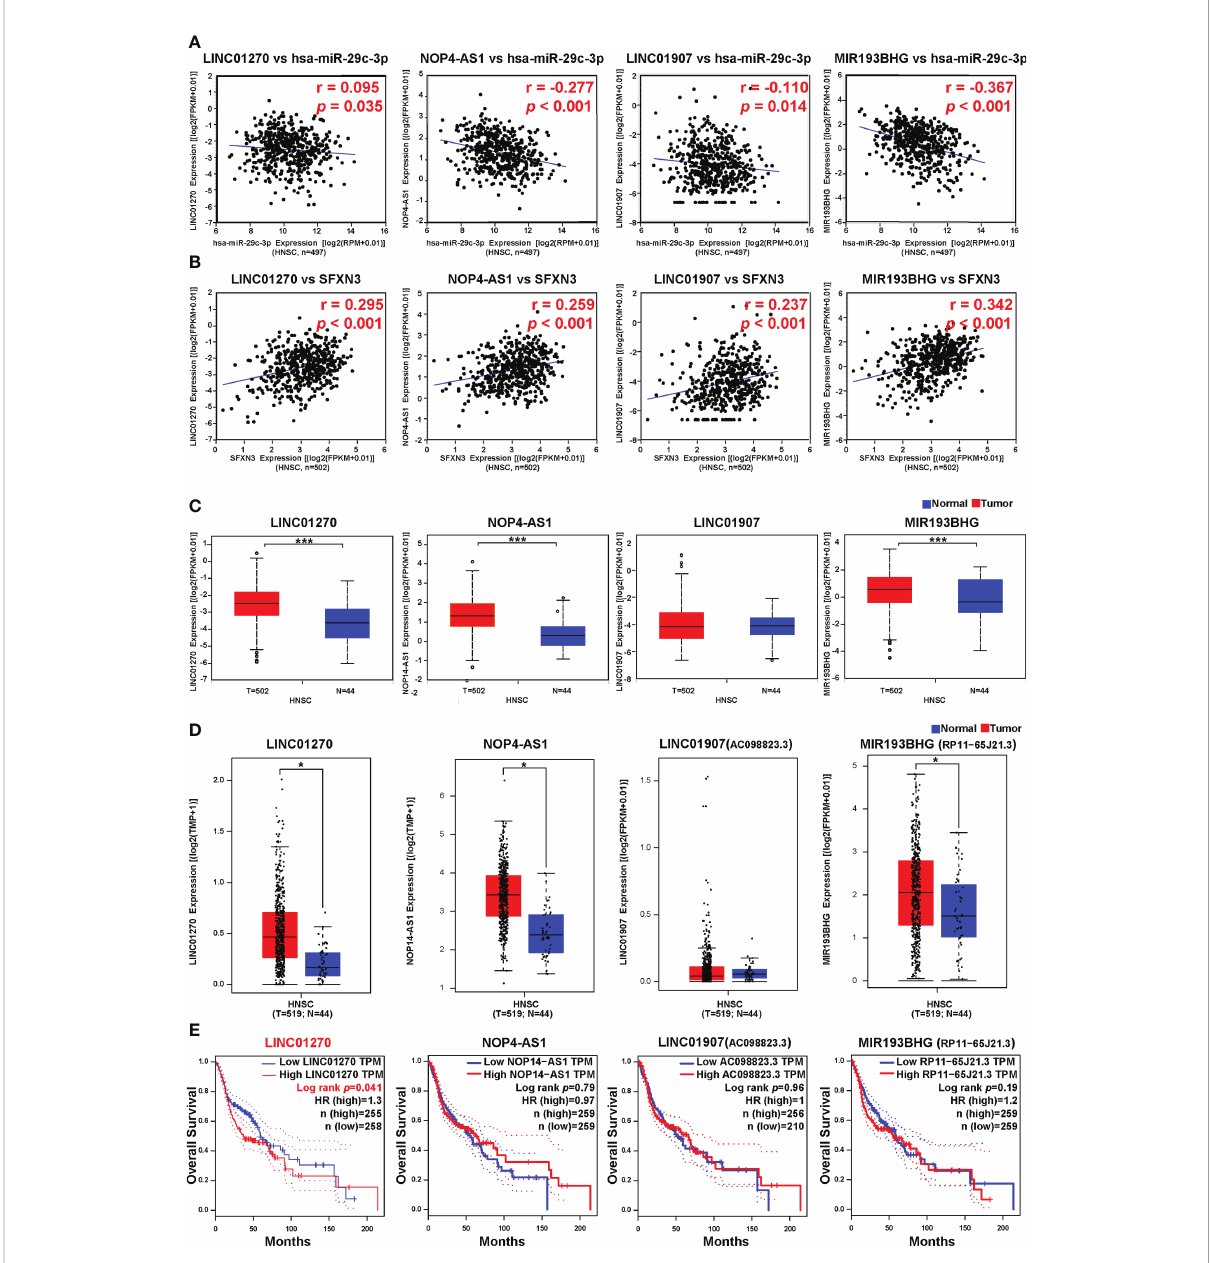
FIGURE 7 Correlation analysis, expression analysis, and survival analysis for upstream lncRNAs of hsa-miR-29c-3p in HNSC. (A) Correlation analysis between hsa-miR-29c-3p and LINC01270 , NOP14-AS1 , LINC01907 , and MIR193BHG , respectively. (B) Correlation analysis between SFXN3 and LINC01270 , NOP14-AS1 , LINC01907 , and MIR193BHG . (C) The expression of LINC01270 , NOP14-AS1 , LINC01907 , and MIR193BHG in TCGA HNSC compared with that in normal tissues using ENCORI. (D) The expression of LINC01270 , NOP14-AS1 , LINC01907 , and MIR193BHG in TCGA HCC compared with “ TCGA normal ” or “ TCGA and GTEx normal ” data. (E) The OS analysis for LINC01270 , NOP14-AS1 , LINC01907 , and MIR193BHG in HNSC. * p value < 0.05; *** p value <